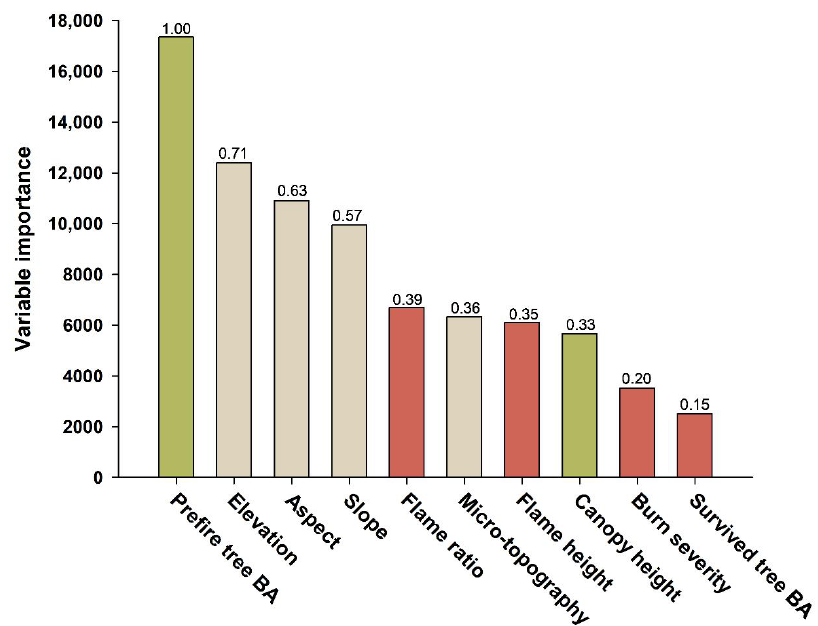
Figure 6. Relative importance of ten fire, site, and prefire vegetation-related variables analyzed using the Random Forest statistical technique. The values shown above each bar indicate the model improvement ratio (MIR). The mean squared error of the Random Forest is 0.31. Prefire tree BA: log 10 -transformed basal area of the prefire trees with resprouting ability, Surviving tree BA: log 10 - transformed basal area of the surviving trees.